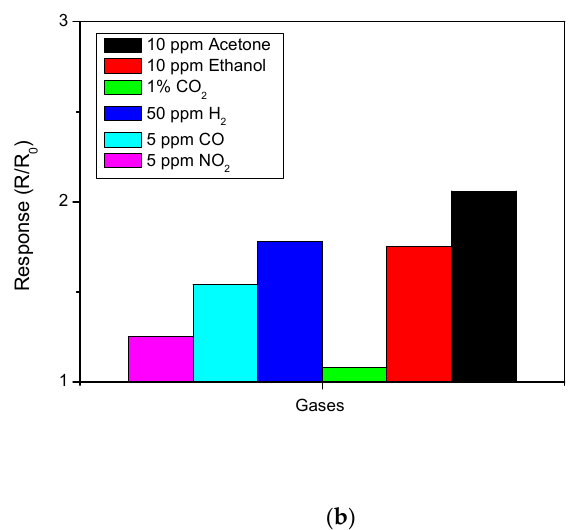
Figure 4. ( a ) Transient response to 50 ppm of H 2 of Co-doped ZnO sensor. ( b ) Comparison of the response of Co-doped ZnO sensor to H 2 , acetone, ethanol, and other environmental interferent gases. Figure 5a and Figure 5b show dynamic resistance curves of pristine ZnO and Co-doped ZnO NPs, respectively, registered at 200 °C toward a pulse of 10 ppm ethanol. As previously mentioned, the Co-doped ZnO sensor shows a lower response to ethanol in comparison to the pristine ZnO the determination of breath hydrogen. The response time is faster for the Co-doped ZnO sensor (less